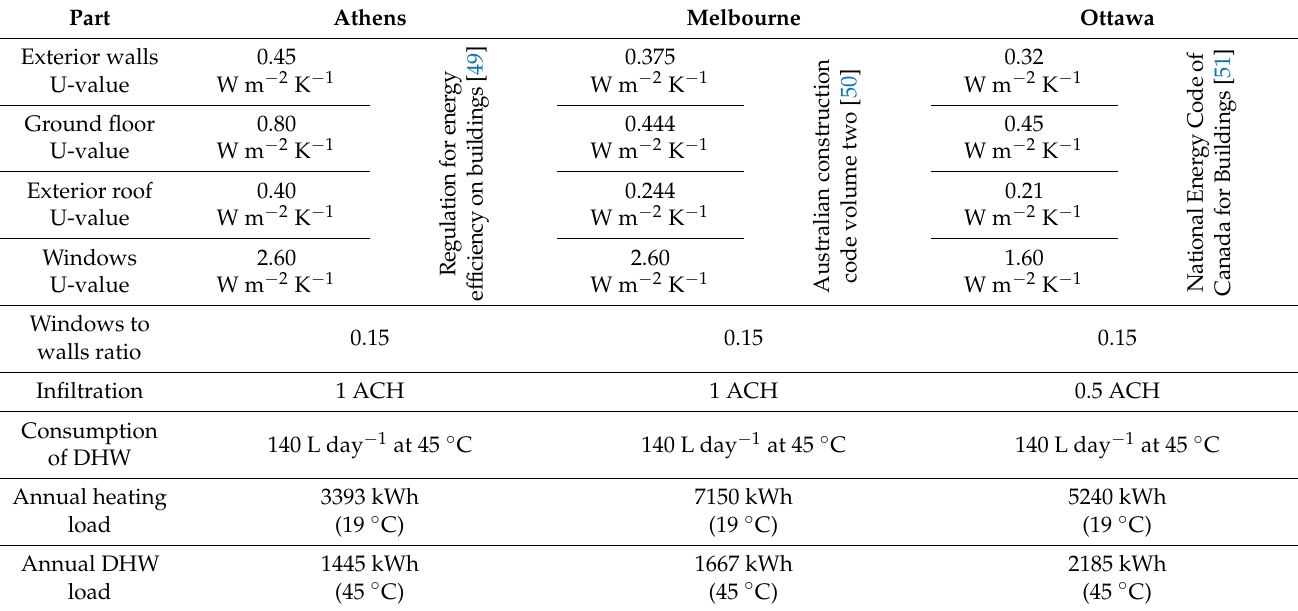
Table 4. Dwellings and DHW main parameters values for all three